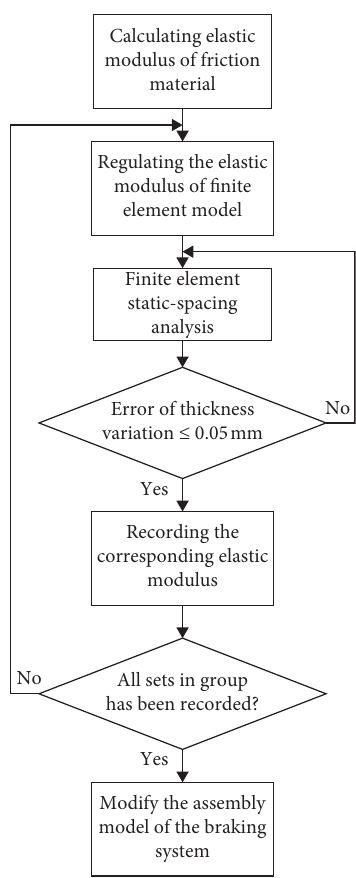
Figure 4: Process of adjusting the compressive strain by regulating the elastic